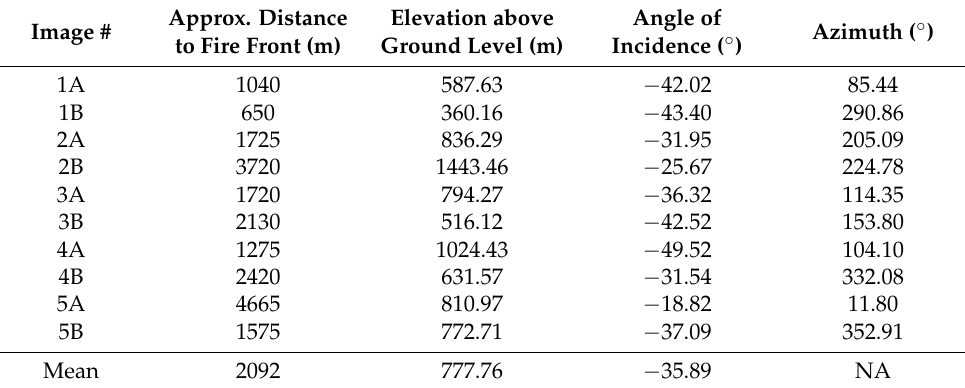
Table 4. The estimated camera characteristics for each georeferenced image.